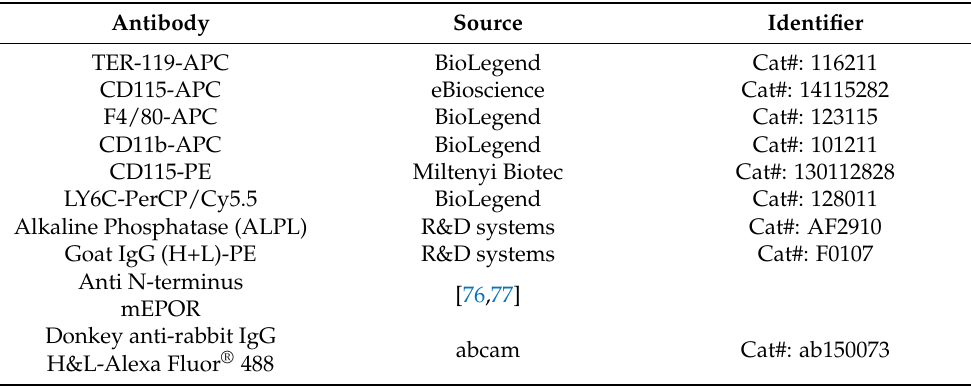
Table 1. Antibodies used for flow cytometry